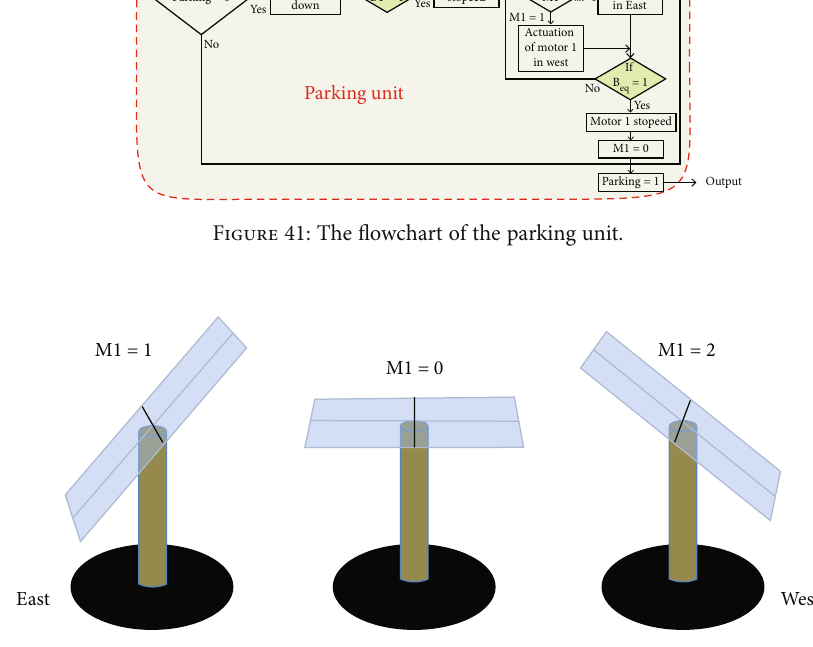
Figure 42: The state of variable M1.